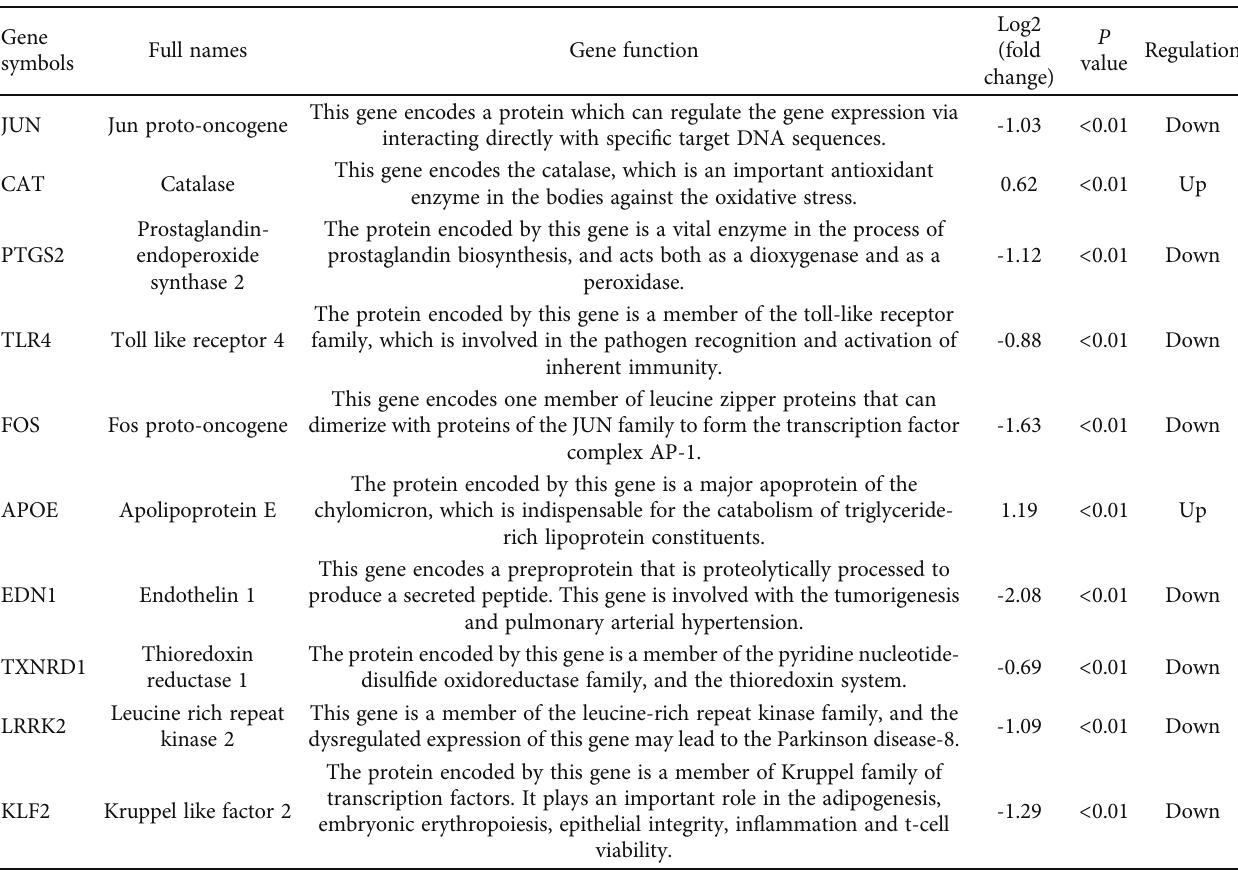
Table 2: Detailed information of top 10 hub